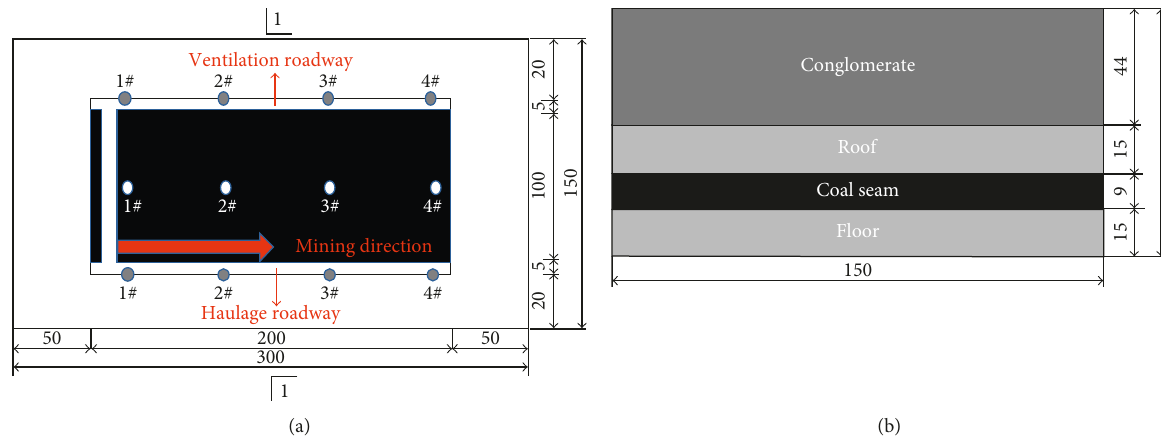
Figure 4: (a) Actual working face layout and measuring points arrangement (unit: m); (b) profile 1 (unit: m).